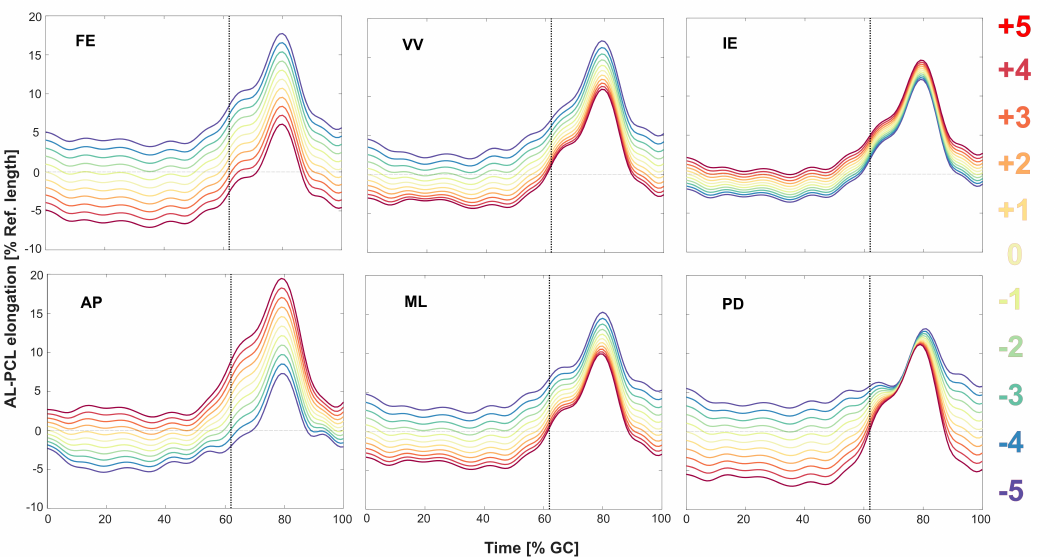
Figure 6. Variation in elongation of the AL-PCL bundle due to perturbing the anterio–posterior (AP), medio–lateral (ML), and proximal–distal (PD) translations as well as the flexion–extension (FE), varus–valgus (VV), and internal–external (IE) rotations of the implant. The baseline kinematics (movement of the tibial component relative to the femoral component) captured from a subject during level walking was perturbed within ± 5 mm / ± 5. The vertical dotted line shows the instant of toe-o ff